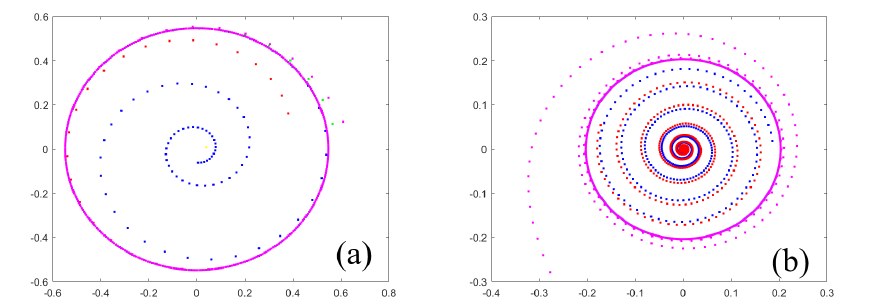
− α + α 2 , β 2 ( α ) = 1 α 2 2 1 − α − α 2 , β 2 ( α ) = − α 1 − 3 α 2 and 1 α 2 2 1